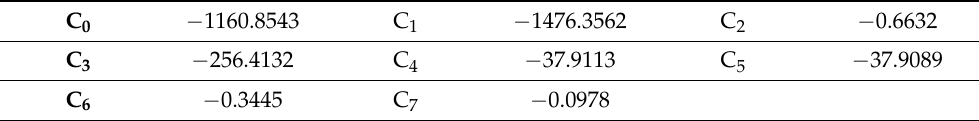
Table 6. Seven coefficients and one constant (for seven input variables corresponding to the physicochemical properties of C 3 S and solvents) optimized for the analytical model of the alka- line solvent scenario. C 0 − 1160.8543 C 1 − 1476.3562 C 2 − 0.6632 C 3 −